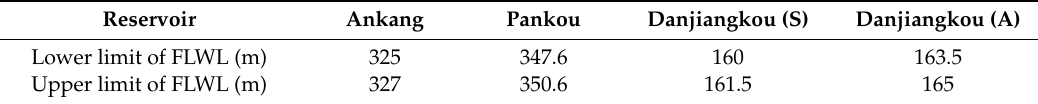
Table 2. The FLWL dynamic control bound of Danjiangkou, Pankou and Ankang reservoirs.